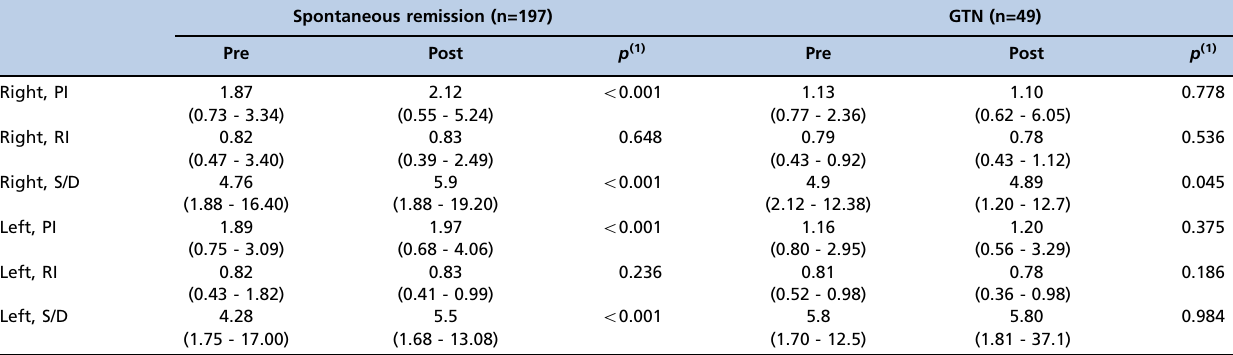
Table 2 - Pre- and post-evacuation uterine artery Doppler flow velocimetry in women who achieved spontaneous remission and those who developed GTN. Spontaneous remission